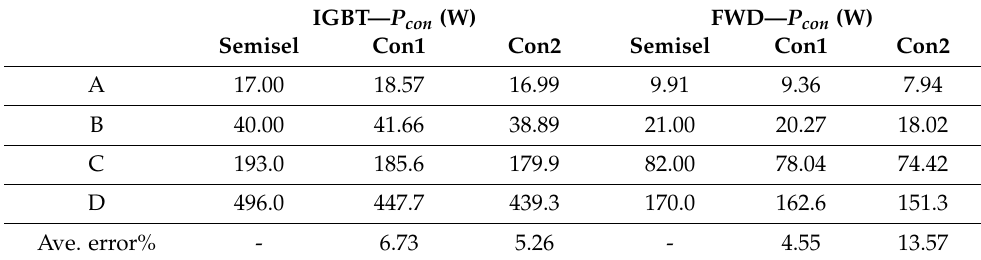
Table 11. Conduction losses comparison, V DC = 500 V.